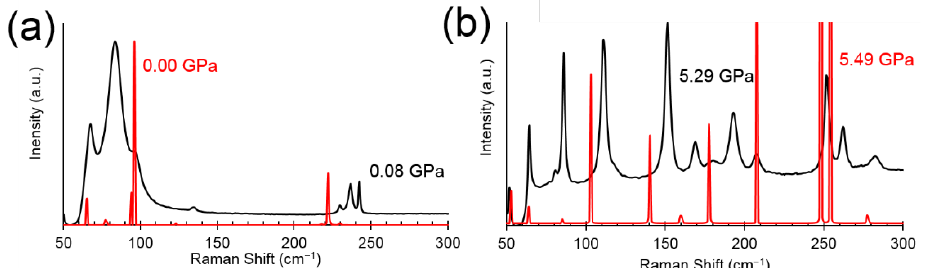
Figure 3. Comparison of the lattice phonon regions in the Raman spectrum of 4-iodobenzobitrile. ( a ) Phase I at ca. ambient pressure. Black: measured at 0.08 GPa in a diamond anvil cell, red: calculated form the ambient-pressure crystal structure by periodic DFT. ( b ) Phase II at ca 5.5 GPa. Black: measured at 5.29 GPa, red: calculated from the crystal structure at 5.49 GPa.